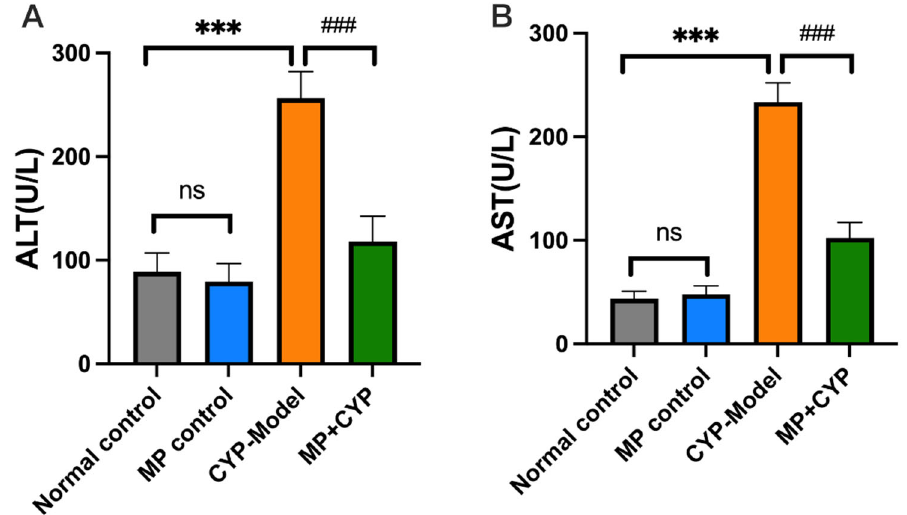
Figure 4. Levels of serum transaminase in different groups of mice ( n = 12). ( A ) Alanine aminotrans- ferase (ALT); ( B ) Aspartate aminotransferase (AST). *** p < 0.0001 compared with Normal Control group; ### p <0.0001 compared with CYP Model group. Data are expressed as means ± SEM.